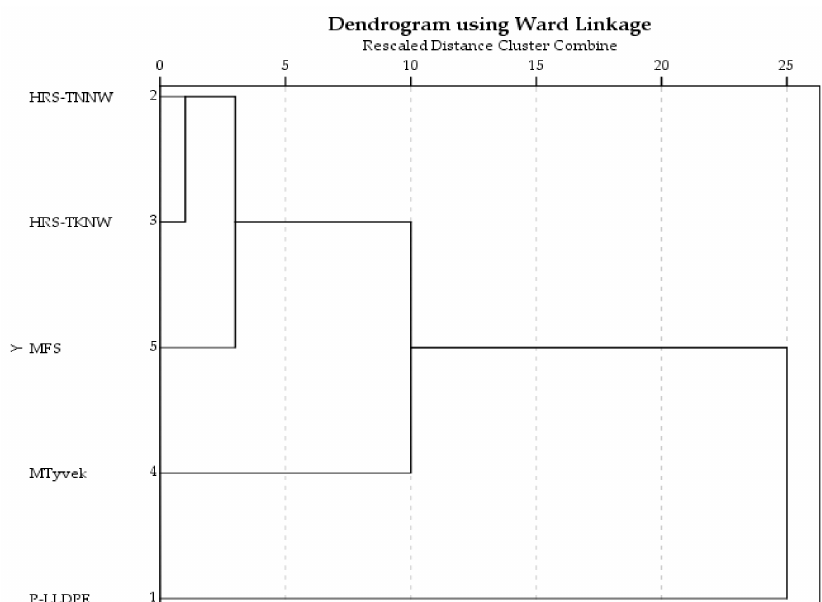
Figure 14. Hierarchical cluster analysis based on material properties, transpiration rate, vital heat, air and pulp temperatures and okra quality. Ward’s method for dissimilarity was utilized during agglomerative hierarchical